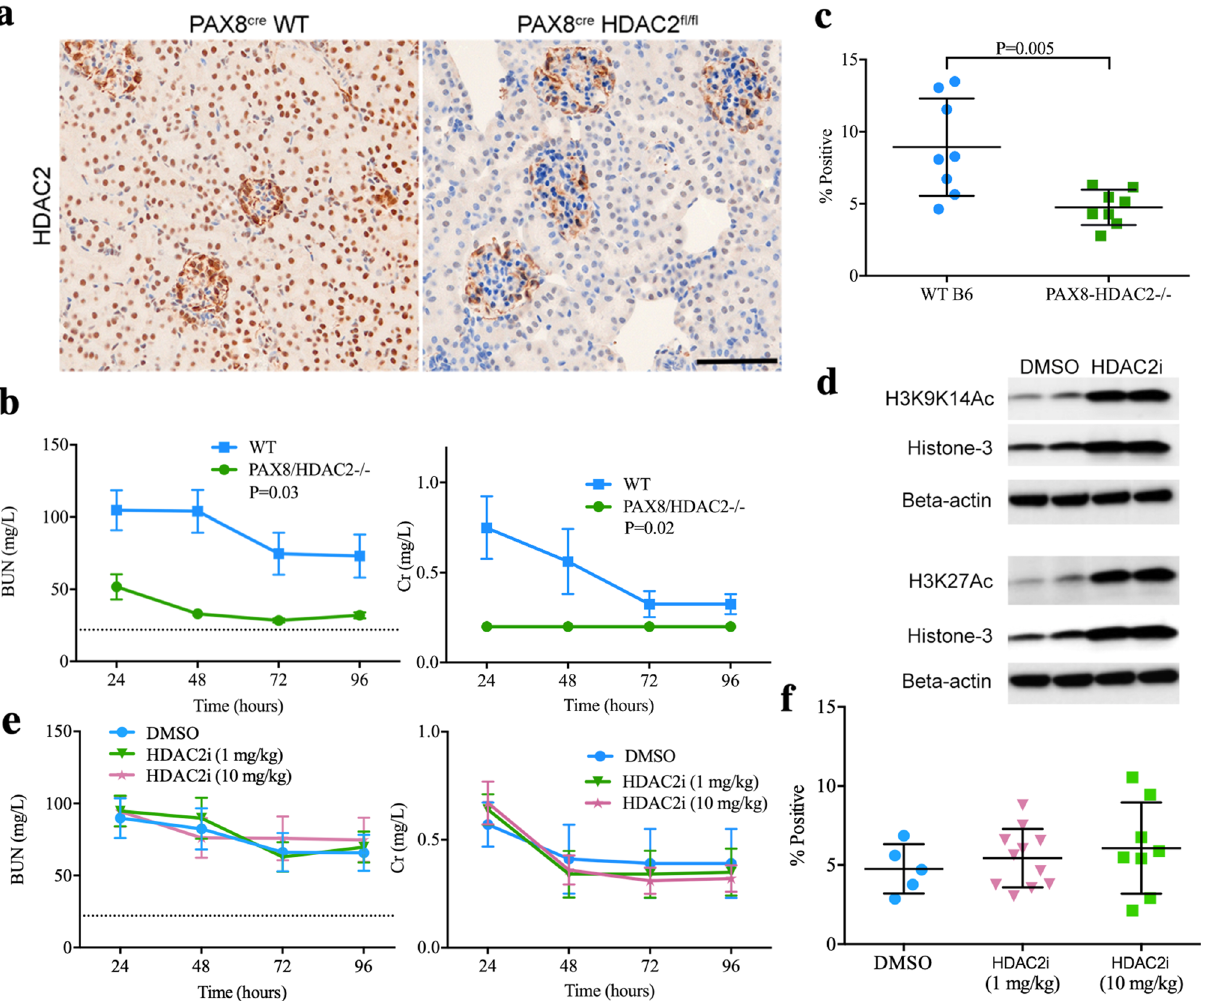
Figure 5. ( a ) Immunoperoxidase staining showed that compared to PAX8 cre controls, PAX8 cre HDAC2 fl/fl mice showed decreased expression of HDAC2 within renal tubules on immunohistochemistry; hematoxylin counterstain, scale marker = 50 µM. ( b ) BUN and Cr following 28 min of warm IRI in PAX8 cre HDAC2 f/fl (PAX8/ HDAC2-/-) and PAX8 cre control mice; data are expressed as mean ± SEM, and significance was determined by 2-way ANOVA (n = 8 mice/group). ( c ) Renal fibrosis with Sirius Red staining at 28 days; significance was determined using the unpaired t-test. ( d ) Representative Western blots using nuclear extracts from kidneys from mice treated with HDAC2i (10 mg/kg/day) or vehicle (DMSO); data are representative of 3 independent experiments and original blots, including MS standards, are displayed in Suppl. Fig. 5. ( e ) BUN and Cr and ( f ) computerized scoring of renal fibrosis with Sirius Red staining at 28 days in WT B6 mice treated with low or high dose HDAC2i or vehicle (DMSO). Data are expressed as mean ± SEM for ( e ) and mean ± SD for ( f ), and significance was assessed by 2-way ANOVA for ( e ) and by unpaired t-test for ( f ); there were no significant differences for either dose of HDAC2i and vehicle (panels ( e , f